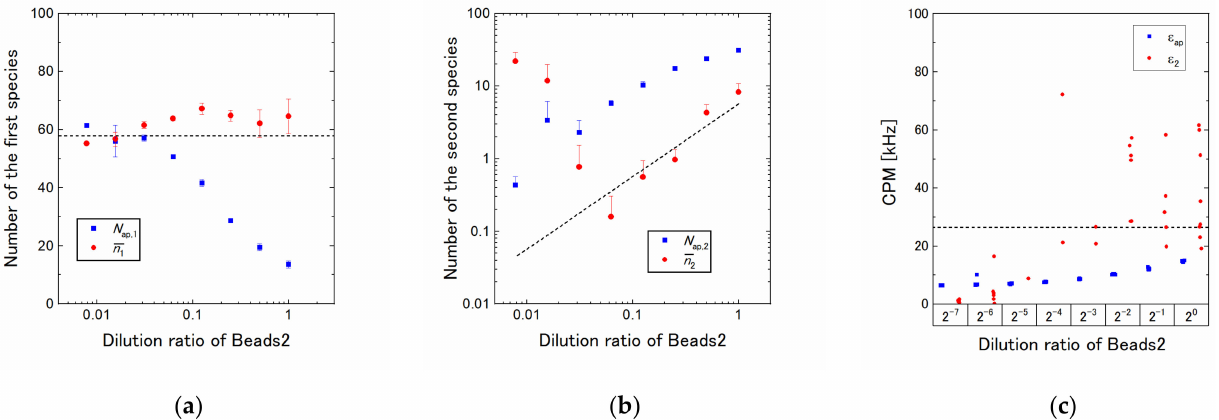
Figure 3. Dependency of the given CPM of the second species. ( a ) Dependency on the measured concentration of the first species C 1 . ( b ) Dependency on the measured concentration of the second species C 2 . Only the error bars in positive direction are shown. ( c ) Dependency on the measured CPM. Black broken lines show the expected values. Error bars show the standard errors ( n =